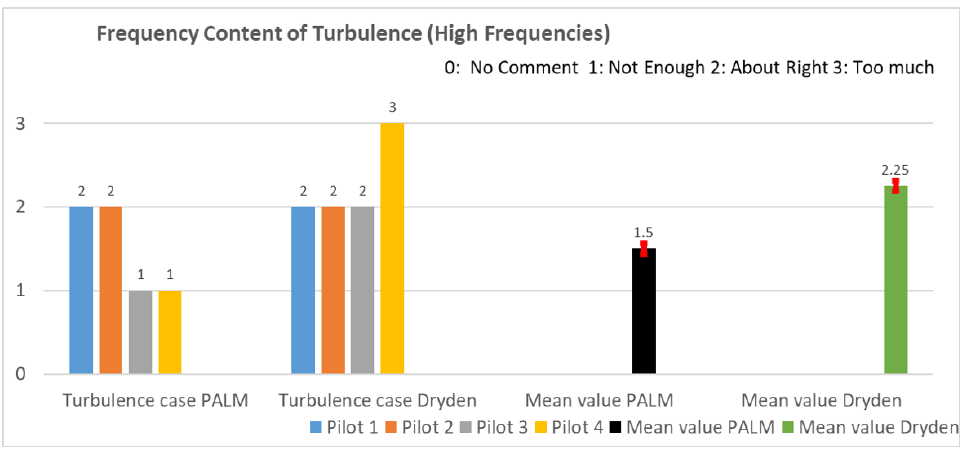
Figure A10. Frequency content of turbulence (high frequencies).